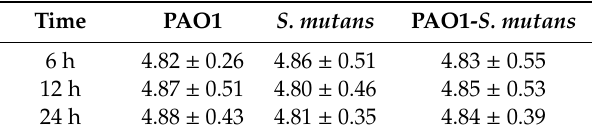
Table 1. pH of the bacterial cultures.